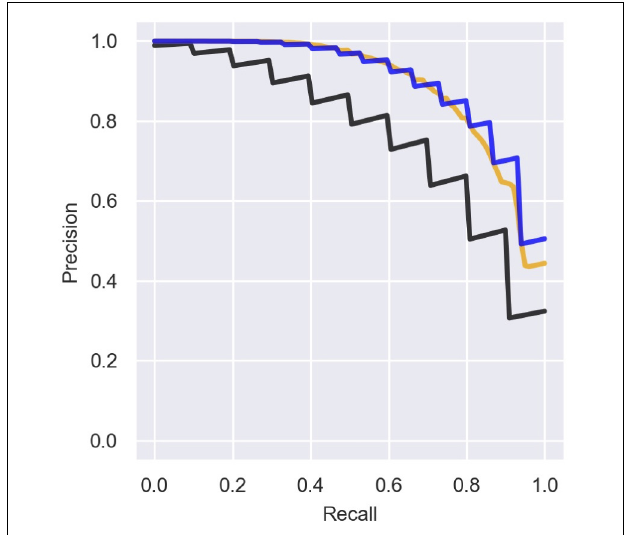
FIGURE 6 | Precision of the predictions with and without labeling of novel sRNAs. Presented is a comparison of the mean precision–recall (PR) curve over the logistic regression iterations for different sets of known sRNAs. We consider three cases: (1) Precision curve as in Figure 3 (black line), when only sRNAs marked by 1 in Supplementary Table 1 are considered as known sRNAs in both training and test sets. (2) The training is done with known sRNAs as in (1) but for the assessment we label all the sRNAs in Table 2 as known sRNAs (orange line). (3) RNAs from Table 2 are labeled as sRNAs for the training and for the assessment (blue